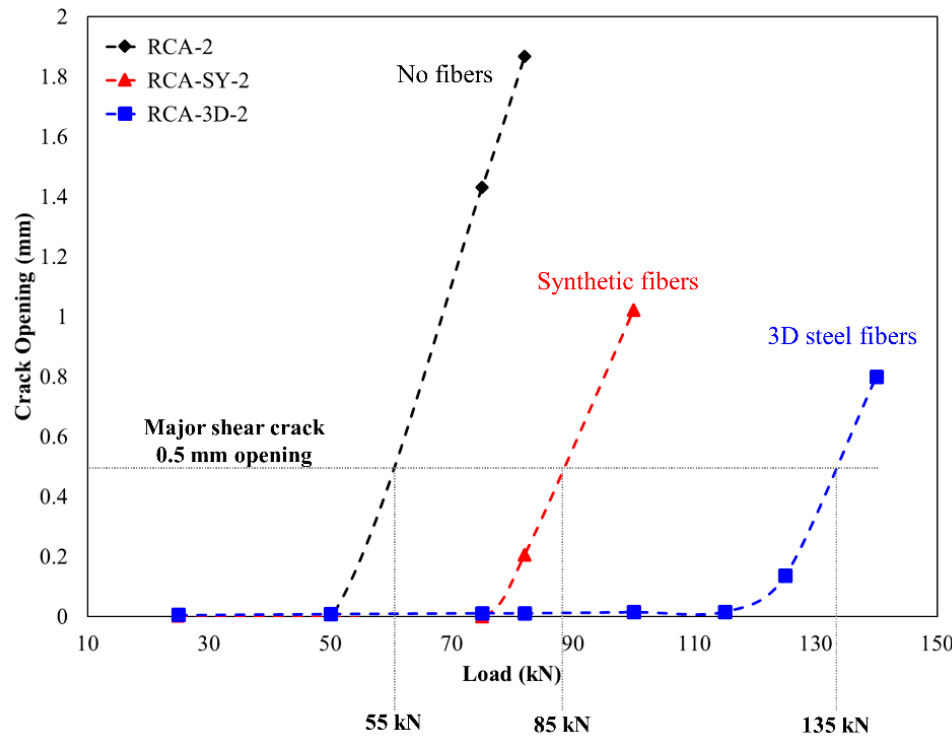
Figure 14. Major shear crack opening versus load for three different cases.